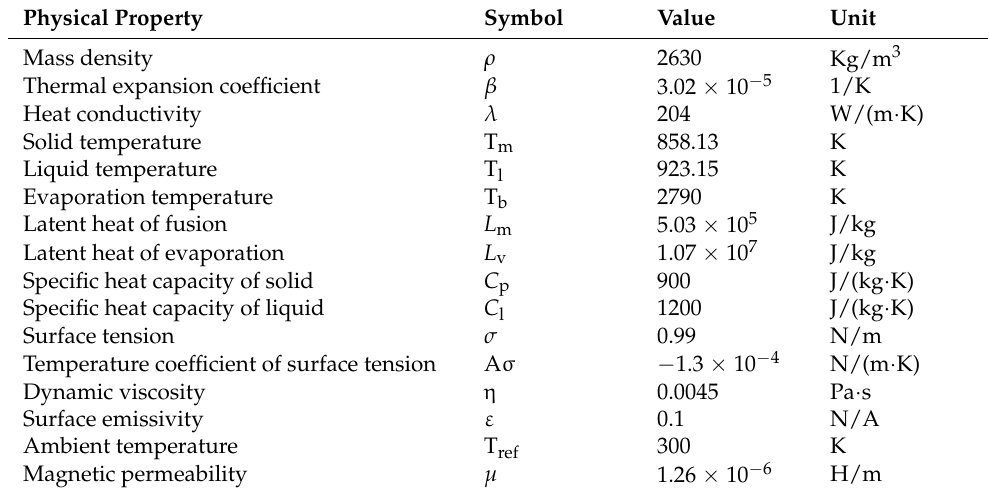
Table 3. Thermo-physical properties of 6061 aluminum alloy for simulation